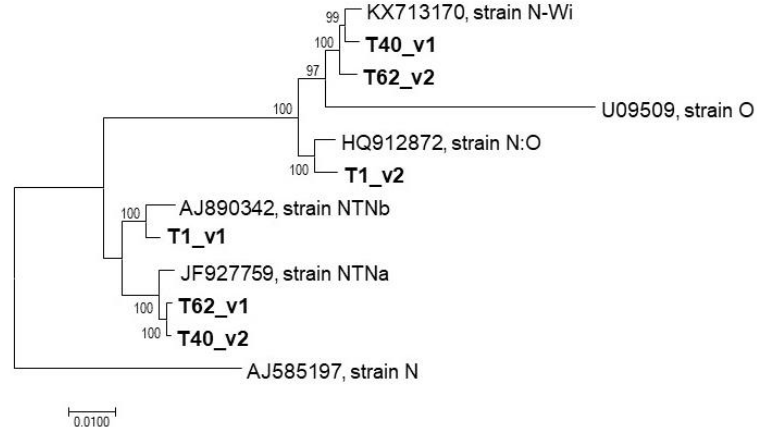
Figure 3. Phylogenetic analysis of PVY variants identified in mixed infections. The phylogenetic tree reconstructed from nearly complete genomes of T1, T40, and T62 variants and selected reference genomes using the neighbor-joining algorithm implemented in MEGA v.7.